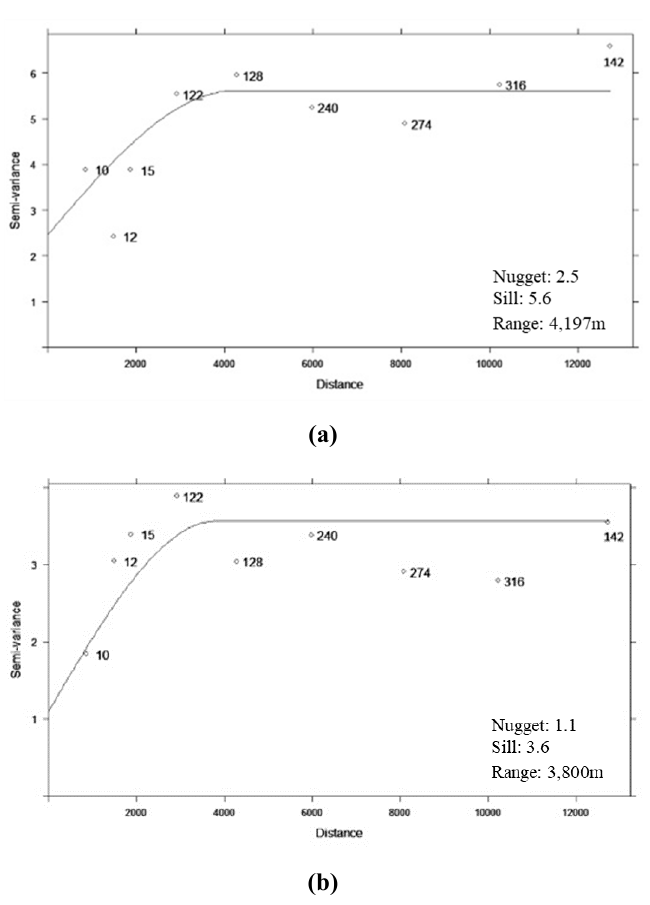
Figure 13. Experimental variogram and fitted variogram model with the 75 GCP dataset: ( a ) error X; ( b ) error Y.